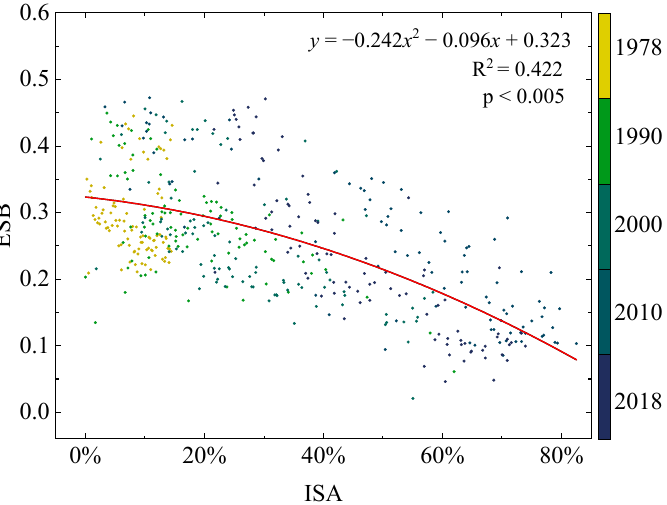
Figure 7. The fitting curve of the urbanization influences ES bundles during 1978–2018.